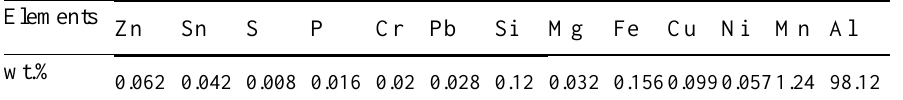
Table 1. Chemical composition of Aluminum